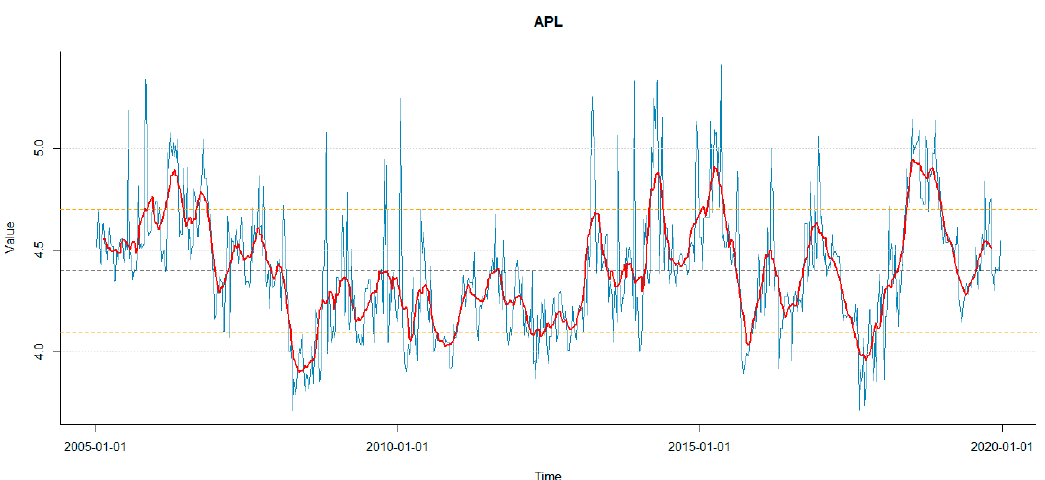
Figure 6. Average path length in the period from 7 January 2005 to 20 December 2019. Red lines depict the 13 periods of the moving average smoothed series. Source: Own study.